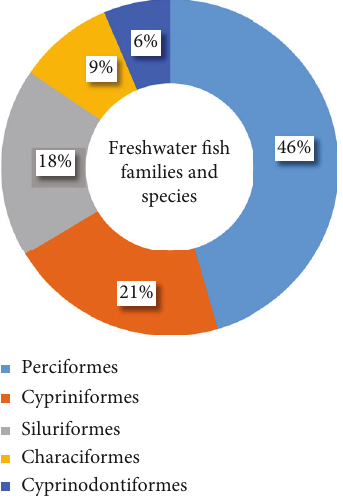
Figure 1: Composition of freshwater fi sh families and species by abundance as reported by Vander Sleen and Albert